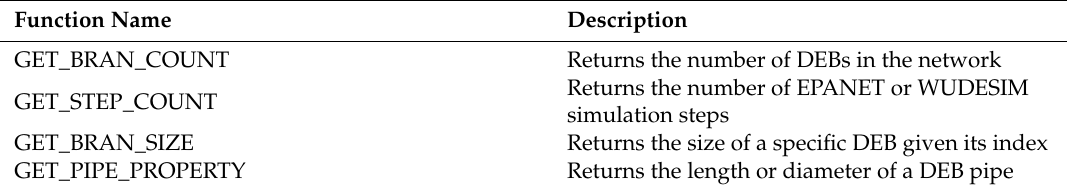
Table 4. Description of Get Property Functions.